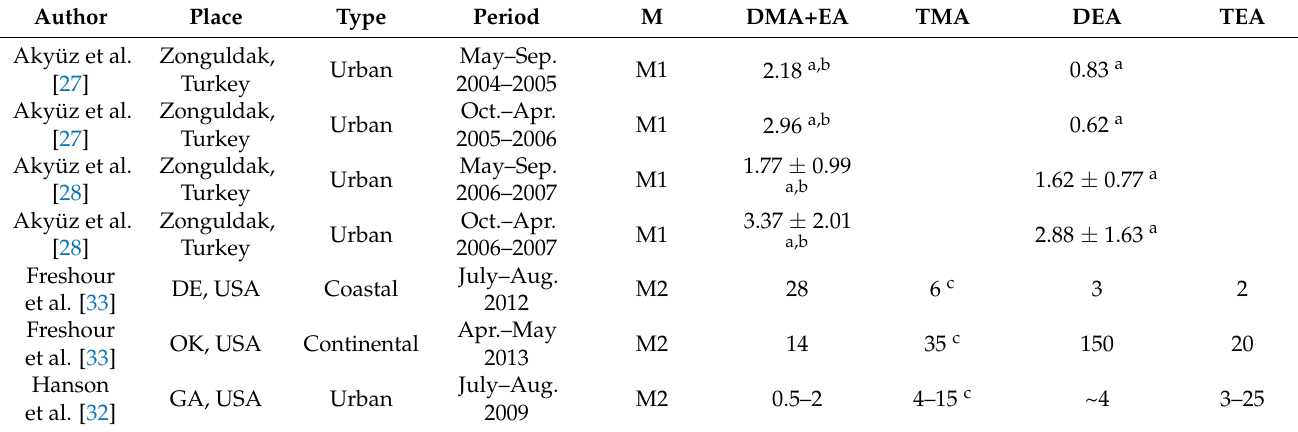
Figure 1. Average concentrations of DMA+EA, TMA, DEA and TEA measured in different environments as they are reported in Table 2 (box plots with solid lines) and measured at Finokalia (box plots with dashed lines). Whiskers represent the 5th and 95th percentiles, box edges are 25th and 75th percentiles, the line in the box is the median, the open square is the mean of the reported values, concentration in pptv. Table 2. Comparison of this work with gaseous amines measured in different environments means (with standard deviation when available) or range (minimum to maximum) of concentrations (in pptv). Column M provides information on the analytical method.